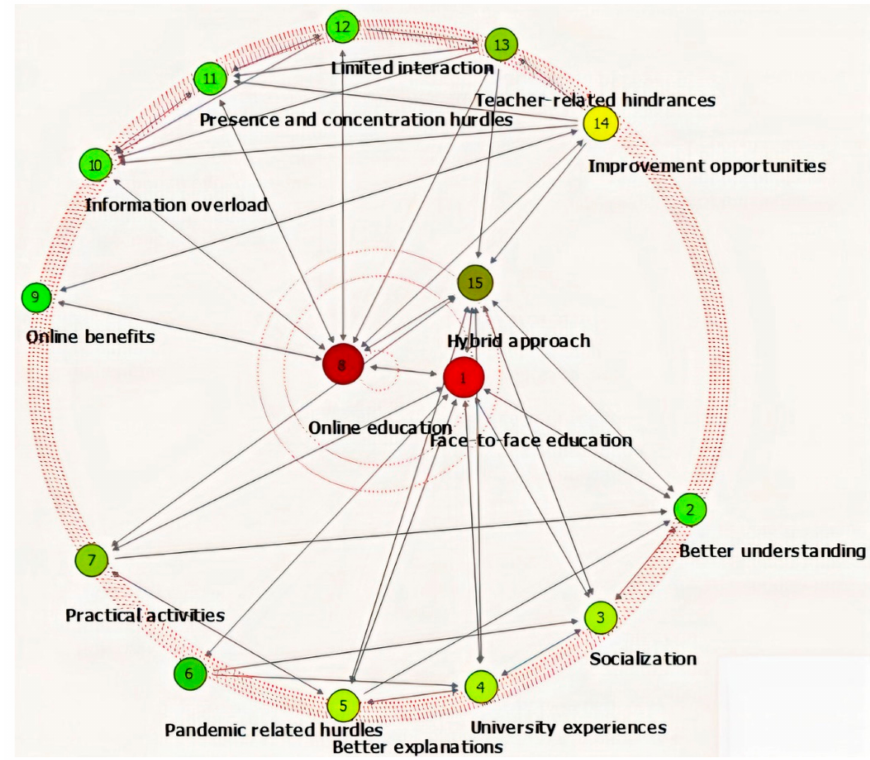
Figure 2. Relationships between retrieved